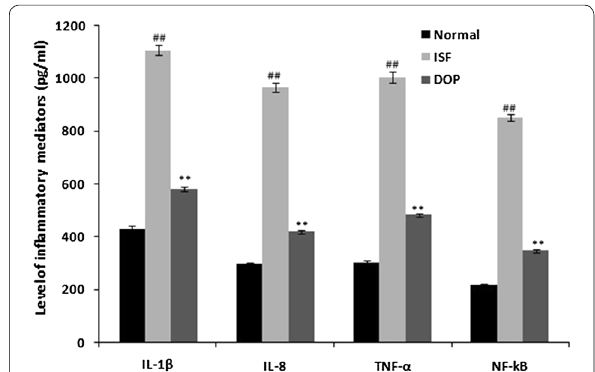
Fig. 4 Desoxyrhapontigenin ameliorates the levels of cytokines in the brain tissues of rats with anaesthesia-induced neuronal